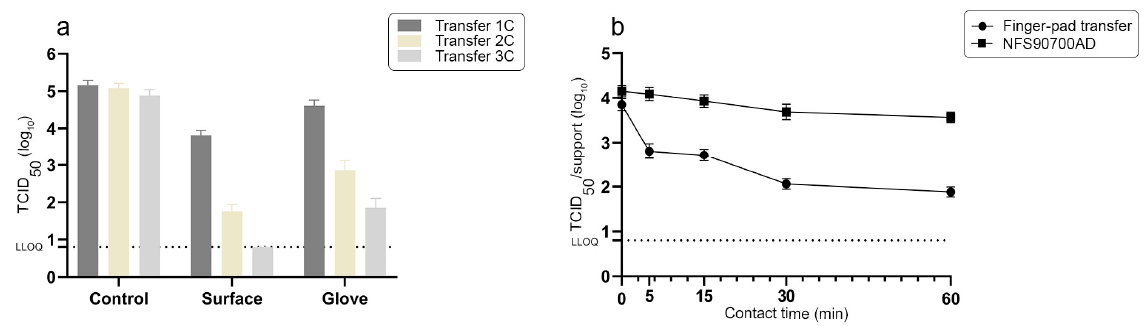
Figure 4. ( a ): Amount of infectious murine norovirus at T0 transferred from artificially contaminated gloved fingertip to stainless steel supports (surface); residual quantities of virus on gloved fingertip after the viral transfer (glove) and from direct washing of fingertips prior to transferring to the surfaces (control). Transfers 1C, 2C and 3C correspond to data obtained after the 1st contact, the 2nd contact and the 3rd contact, respectively. Mean values ± SD corresponding to 10 independent viral transfer experiments for each condition ( b ): Survival of murine norovirus on stainless steel surfaces over time after inoculation by finger-pad viral transfer (first contact) or by a viral solution deposit (NFS90700AD procedure). LLOQ: lower limit of quantification (LLOQ = 0.8 log 10 TCID 50 ). Mean values ± SD corresponding to 10 inoculated supports for each time point.